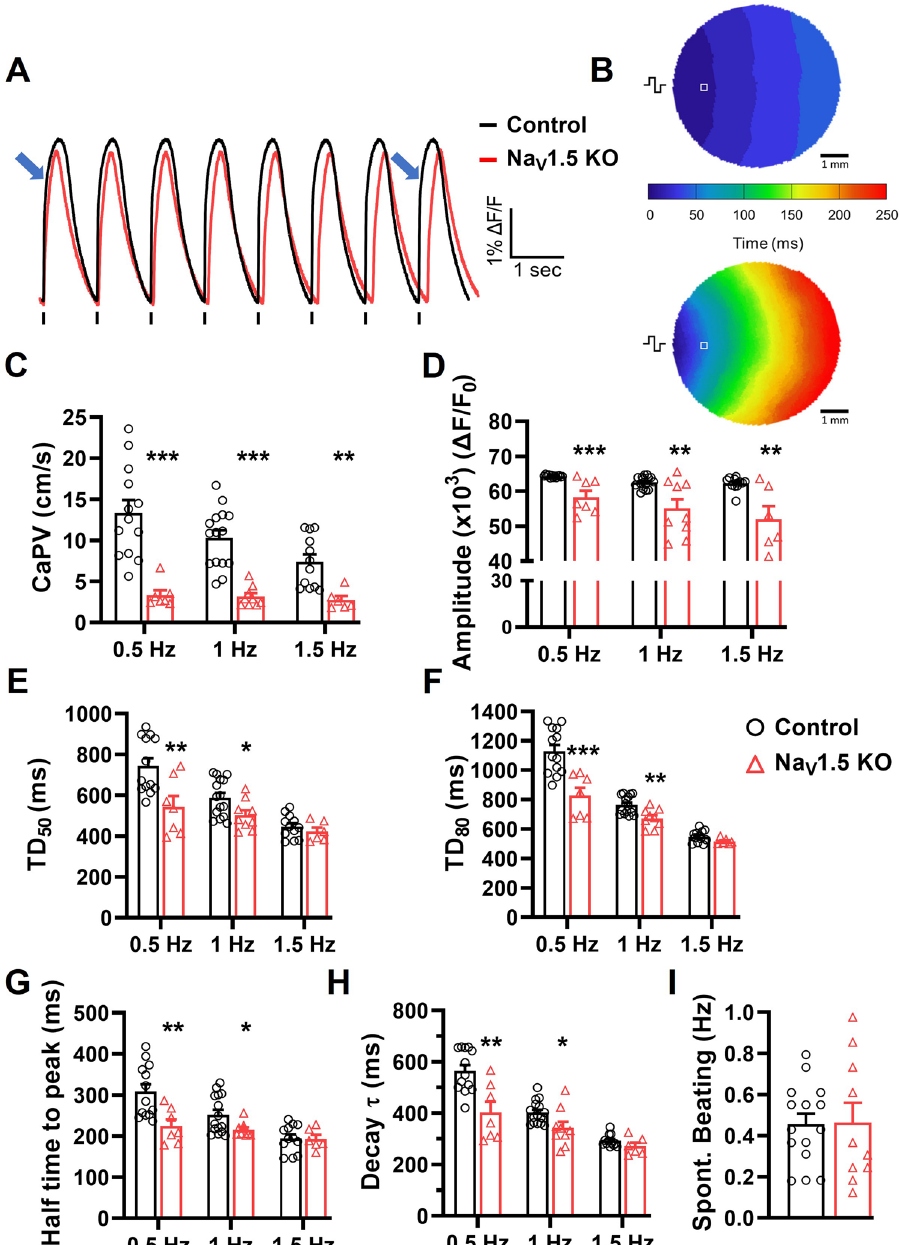
Figure 5. Altered calcium handling in Na V 1.5 KO iPSC-CMs monolayers. ( A ) Representative Ca 2+ transient traces of control and Na V 1.5 KO iPSC-CMs monolayers. Blue arrows indicate the Ca 2+ activation delay in Na V 1.5 KO recording. ( B ) Representative Ca 2+ activation maps at pacing of 1 Hz. The symbol indicating the position of stimulating electrodes, and □ showing the position of the representative recordings. ( C ) Bar graphs summarizing the Ca 2+ propagation velocities (CaPVs), ( D ) the normalized amplitude. ( E,F ) the Ca 2+ transient durations at 50 and 80% of the repolarization phase (TD 50 and TD 80 ), ( G ) the half time to peak, and ( H ) the time constant of repolarization (Decay tau) measured at stimulation frequencies of 0.5, 1 and 1.5 Hz in control (n = 12 – 15) and Na V 1.5 KO (n = 6 – 9). ( I ) Bar graphs showing the spontaneous Ca 2+ waves frequencies in control (n = 15) and Na V 1.5 KO (n = 10) iPSC-CM monolayers. A replicate (n) represents a single monolayer of iPSC- CMs on which the optical mapping was performed. Bars indicate SEM. * p < 0.05, ** p < 0.001, *** p < 0.001 as determined by unpaired t-test. This figure was made using MICROSOFT POWERPOINT Version 2106 (build 14131.20278 Office, https:// docs. micro soft. com/ en- us/) and PRISM 8 Version 8.0.2 (263, https:// www. graph pad.